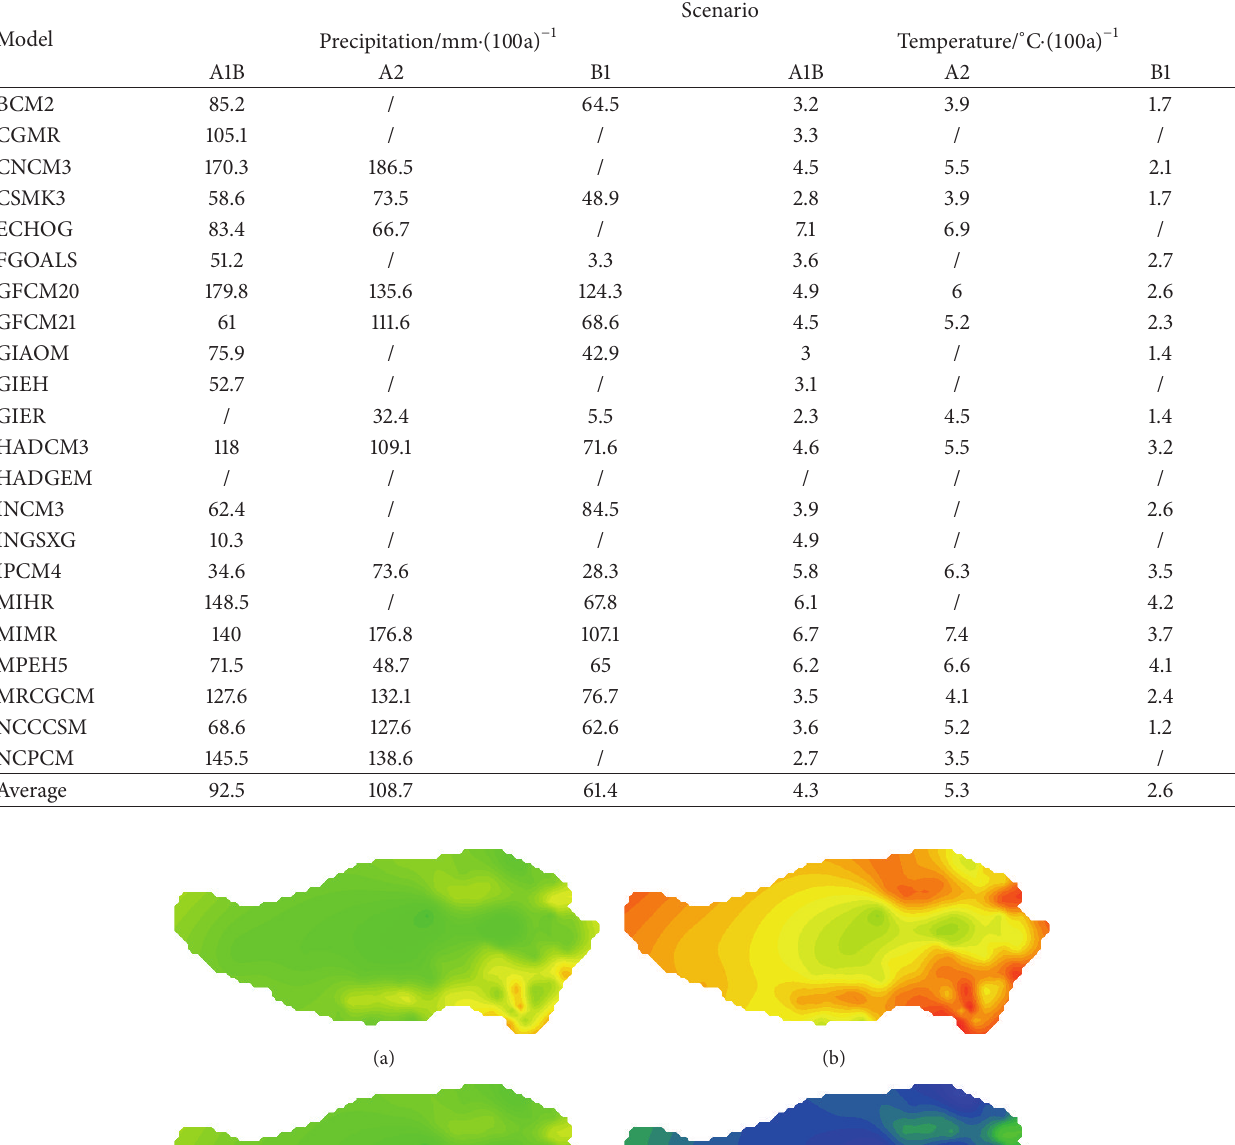
Table 3: Linear trend of temperature and precipitation simulated with models in 2000–2099.